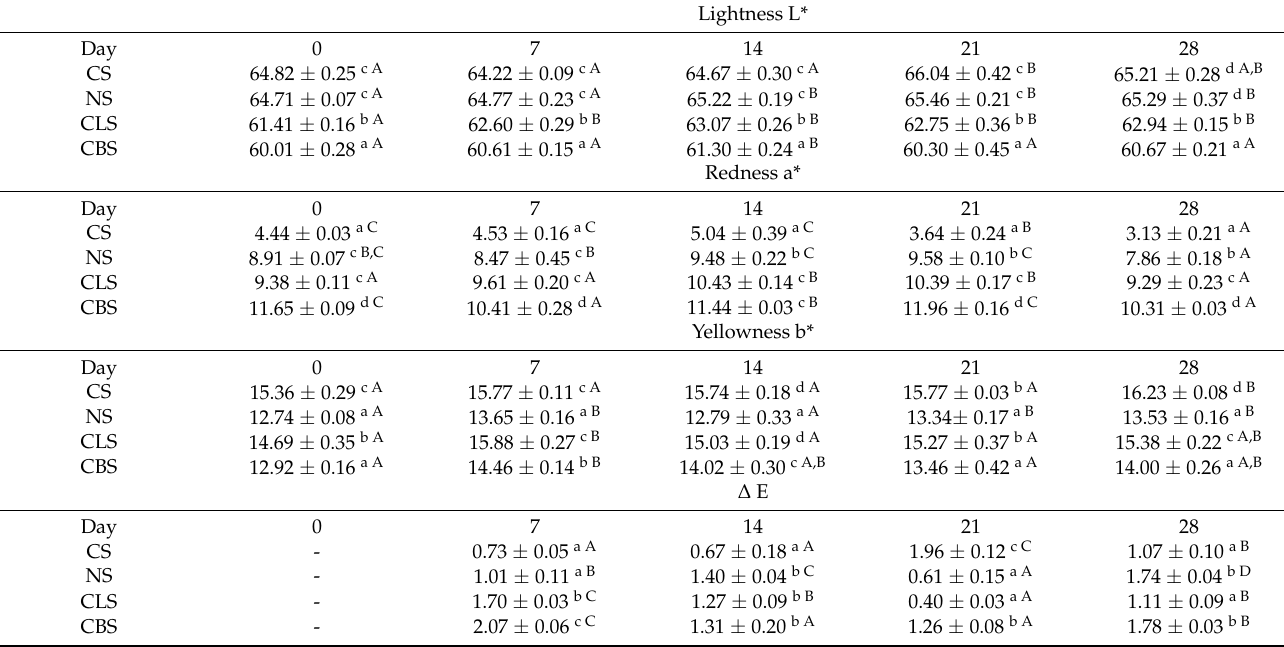
Table 6. Effects of C. incanus extract with lycopene and betanin on color parameters (L*, a*, b*) of pork sausages stored in vacuum packaging at 2 ± 1 ◦ C (mean ± SD, n = 3).